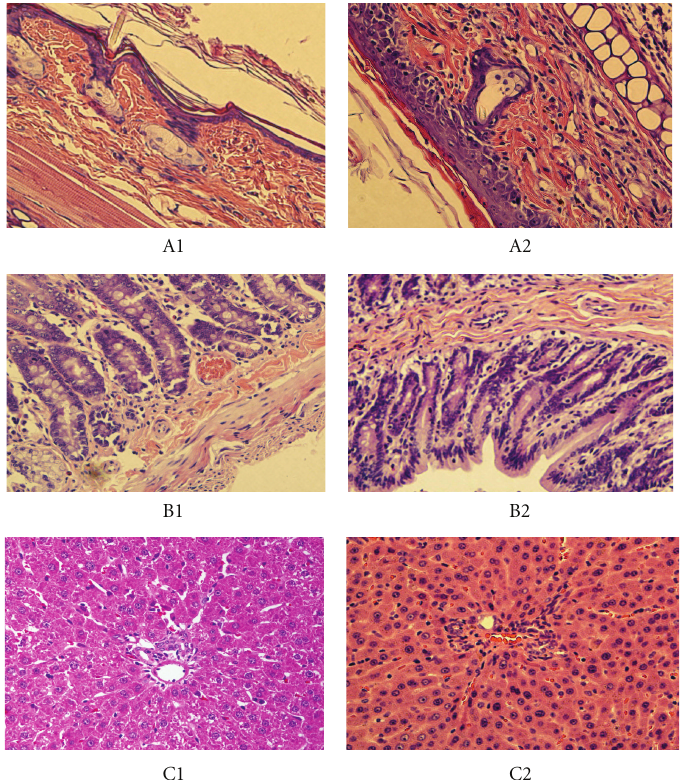
Figure 3: The pathological findings of aGVHD after liver transplantation. (A1) The histologic examination of skin was normal without obvious mononuclear infiltrating. (A2) Epidermis and dermis of the skin were infiltrated by mononuclear cells, and basilar degeneration and necrosis of keratinocytes were also observed. (B1) The histologic examination of intestine was normal without obvious mononuclear infiltrating. (B2) The intestine contained lymphocytic infiltrates. (C1) The histologic examination of liver was normal without obvious mononuclear infiltrating. (C2) No obvious mononuclear infiltrate in the liver. (H&E, original magnification ×